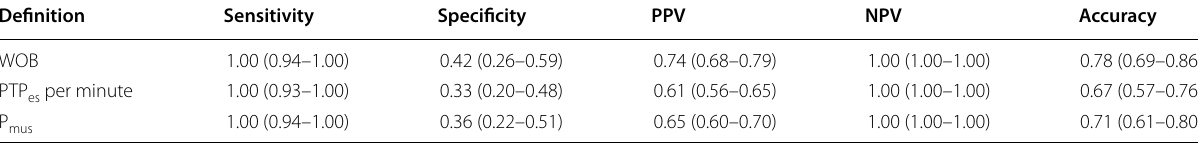
a The cutoff value of flow index derived from the previous study was 2.6 [14] Between parentheses is the 95% confidence interval (95% CI)